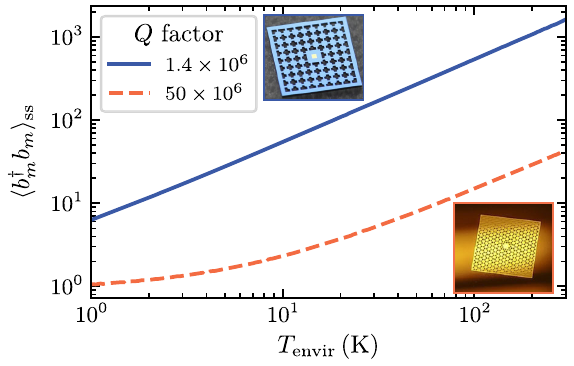
FIG. 5. Simulated steady-state occupation of membranes for varying cryostat temperature and different mechanical Q factors. ¼ 2 g , δ ¼ 0 , and τ ¼ 15 ns. The insets show the current Here, γ s membrane with phononic shield used in these experiments and a soft-clamped membrane for which Q ≈ 5 × 10 7